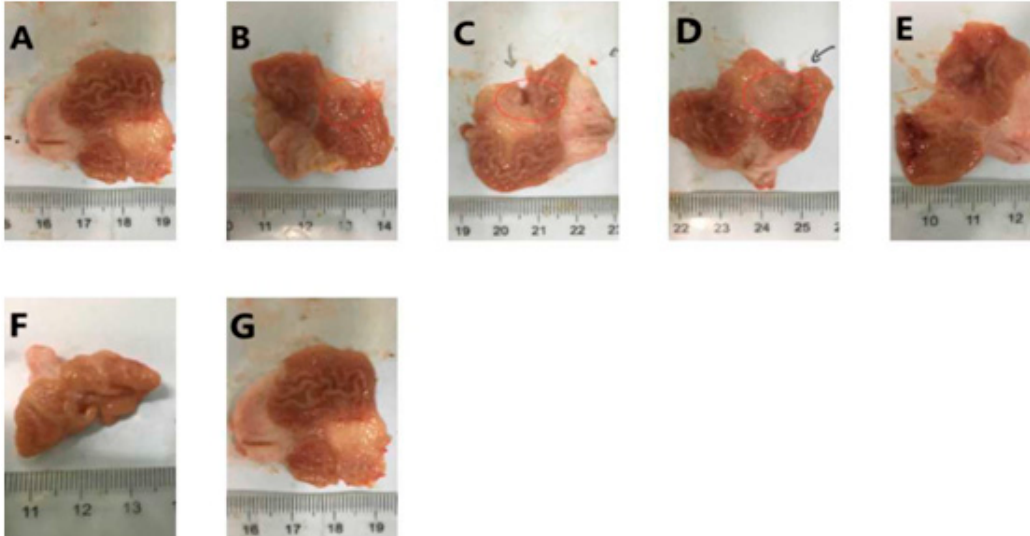
Figure 2. Effects of compound LSZ capsule on the macroscopic appearance of rats’ gastric mucosa, which has been damaged ( n = 6). Seven groups: ( A ) Intact; ( B ) Model; ( C ) reference product of 30-mg enteric-coated capsules of LSZ (2.7 mg/kg); ( D ) LSZ (2.7 mg/kg); ( E – G ) test product of 30-mg capsules of compound LSZ (LSZ:NaHCO 3 ): (1.35 mg/49 mg), (2.7 mg/99 mg) and (5.4 mg/198 mg) for compound LSZ-L, compound LSZ-M and compound LSZ-H groups, respectively. Table 2. The UI and gastroprotection (%) of the compound LSZ capsule with * p < 0.05, ** p < 0.01 compared with model group (mean ± S D; n = 6). Groups UI